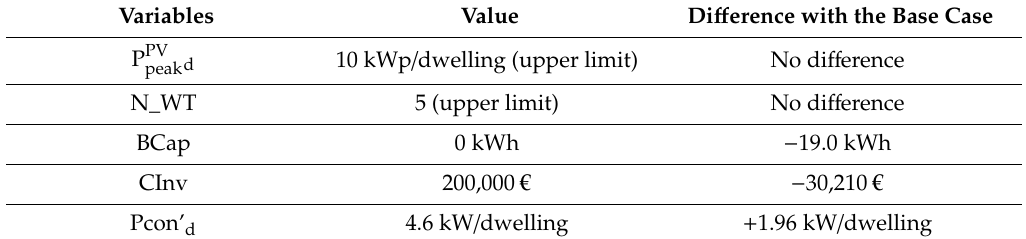
Table 14. Results of the on-grid model with no storage: First-stage variables and objective function.